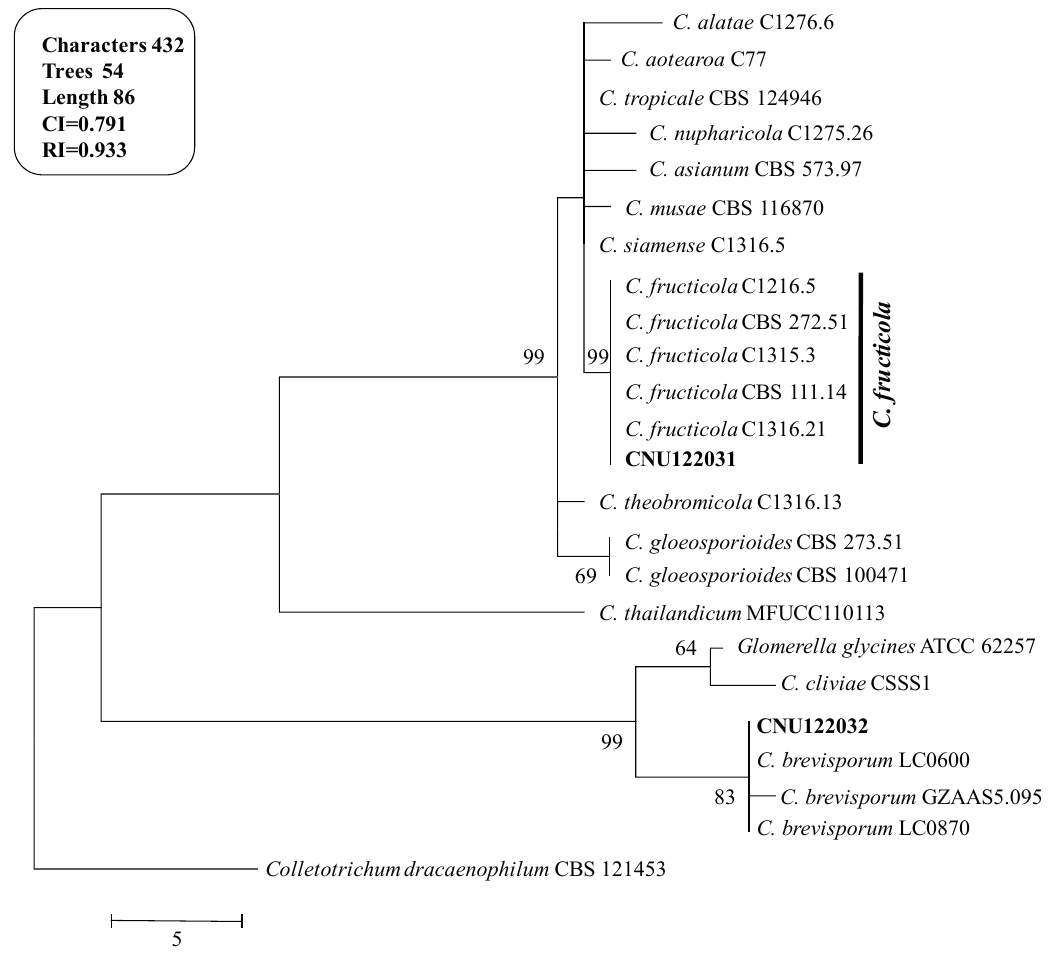
Figure 2. Phylogenetic tree showing the placement of the Colletotrichum isolates from the present study and their related species generated using the maximum parsimony analysis of combined dataset of ITS , ACT, and GAPDH gene sequences. Numbers at the nodes indicate bootstrap values ( > 50%) from 1000 replications. The bar indicates the number of substitutions per position. The tree is rooted with C. dracaenophilum